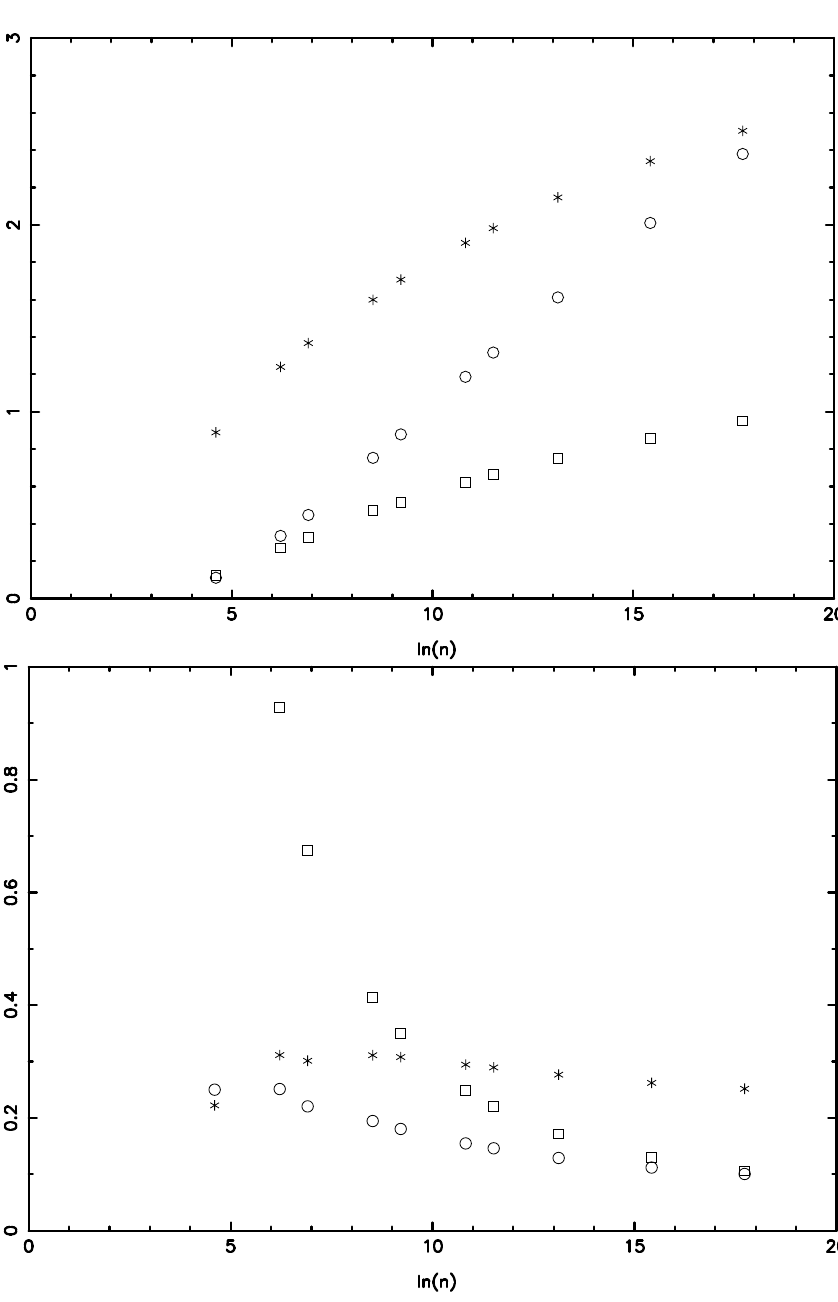
( ν ) vs. ln( n ) . Top: Π n (3) / Π (1) square. Bottom: Π n n (2) / Π (3) n n